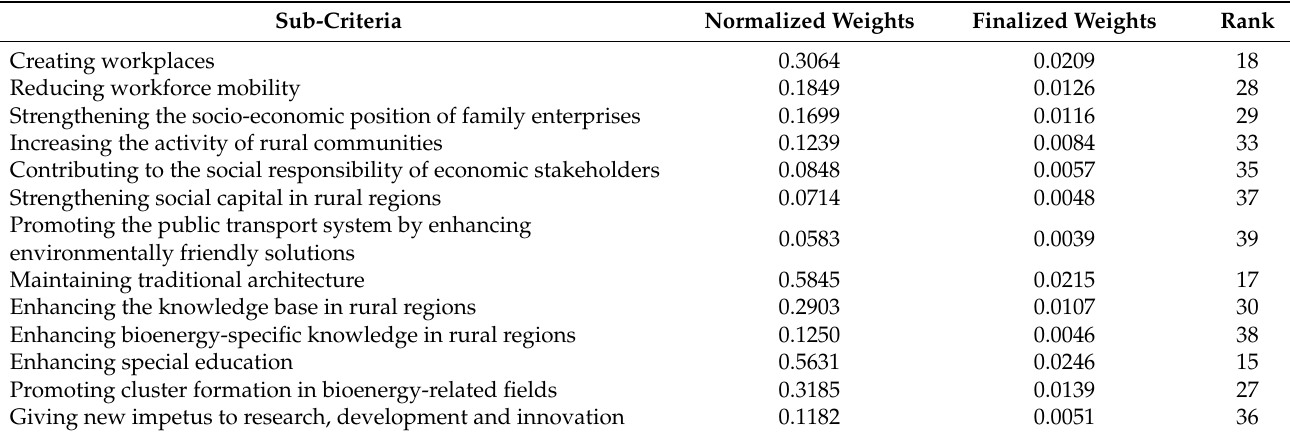
Table 14. Relative importance of social dimension